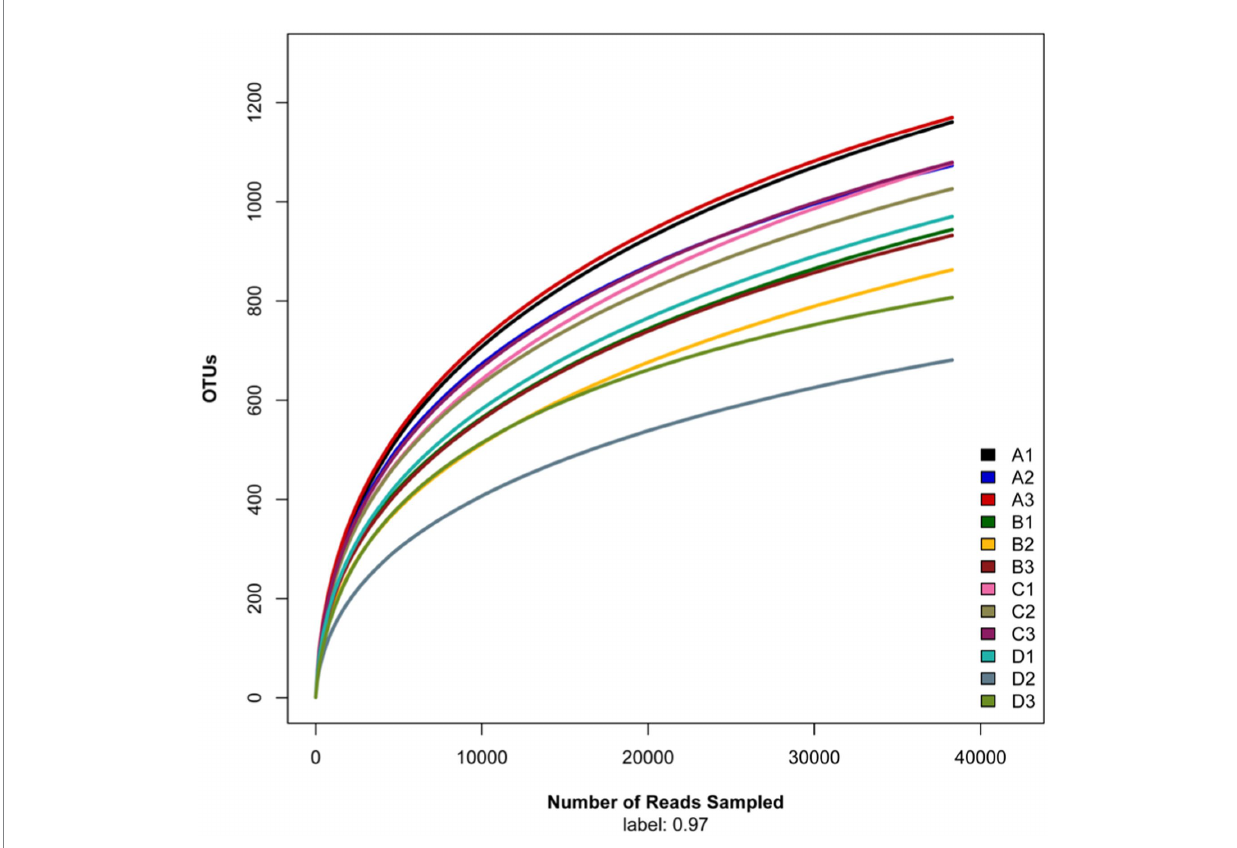
FIGURE 1 Rarefaction curve of fungal sequences in soils along an elevational gradient on the Changbai Mountain, northeastern China. Note A (1–3) is 1,690 m a.s.l.; B (1–3) is 1,800 m a.s.l.; C (1–3) is 1910 m a.s.l.; D (1–3) is 2020 m